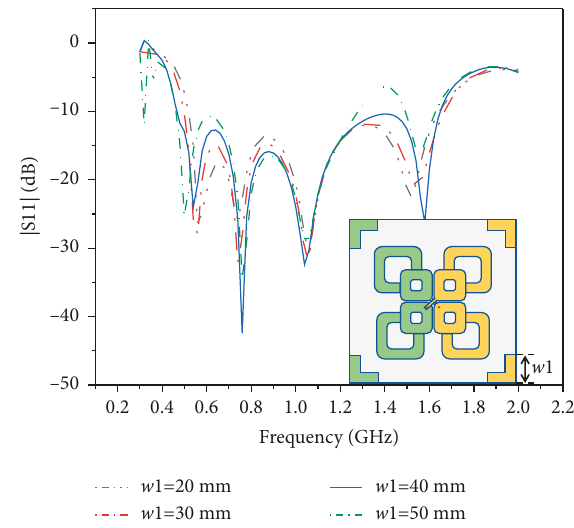
Figure 6: Effect of the length ((w)1) of the parasitic patch on S11.